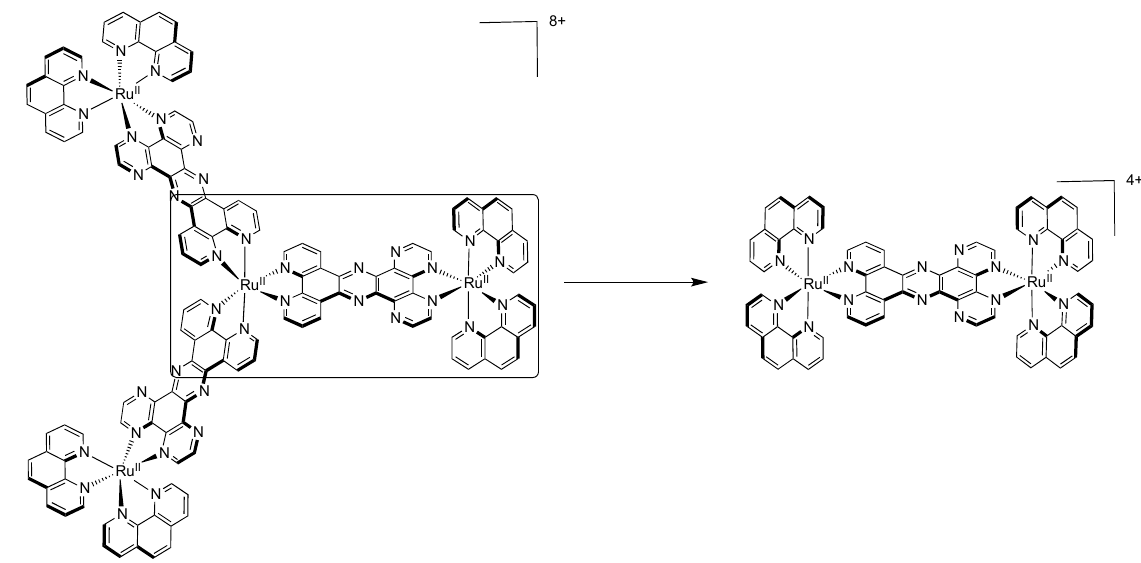
Figure 45 . Schematic representation of a dinuclear subunit present in the dendritic